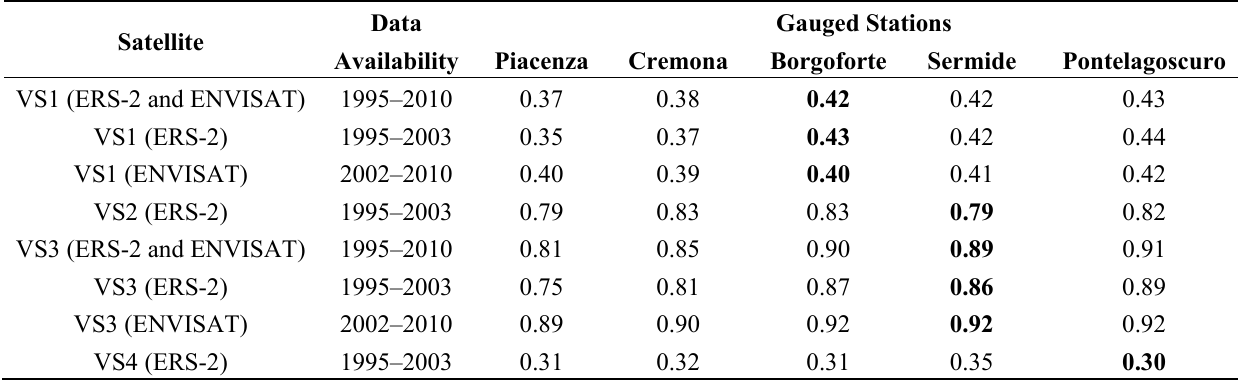
Table 3. Coefficient of correlation between water levels recorded at the in situ gauged station and provided at the virtual stations (VSs) by the satellite altimeter. The gauged sections closest to each VSs are highlighted in